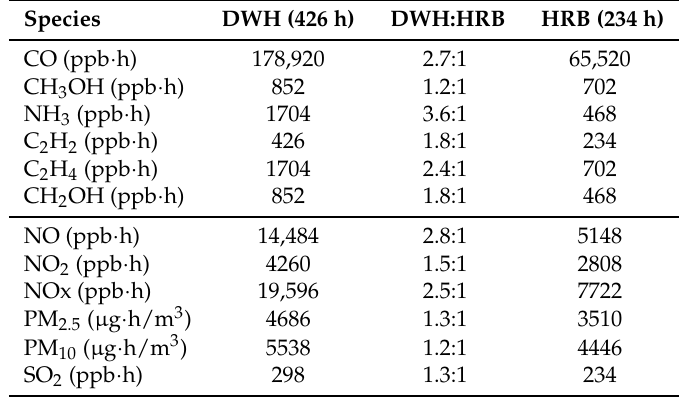
Table 4. Cumulative exposure (enhancements) from domestic wood heating (DWH), hazard reduction burn (HRB) and the ratio between the two (DWH :